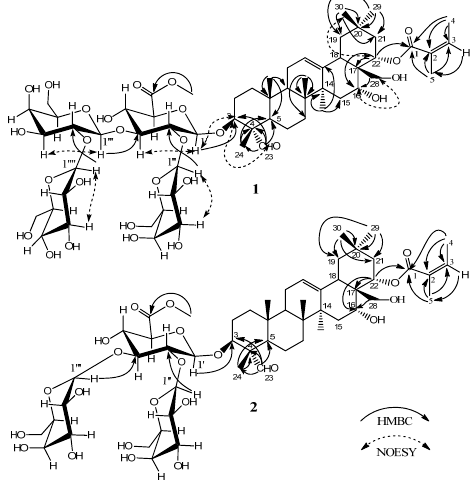
Figure 2. Key HMBC and NOESY correlations within oleiferasaponins C 4 and C 5 ( 1 , 2 ).